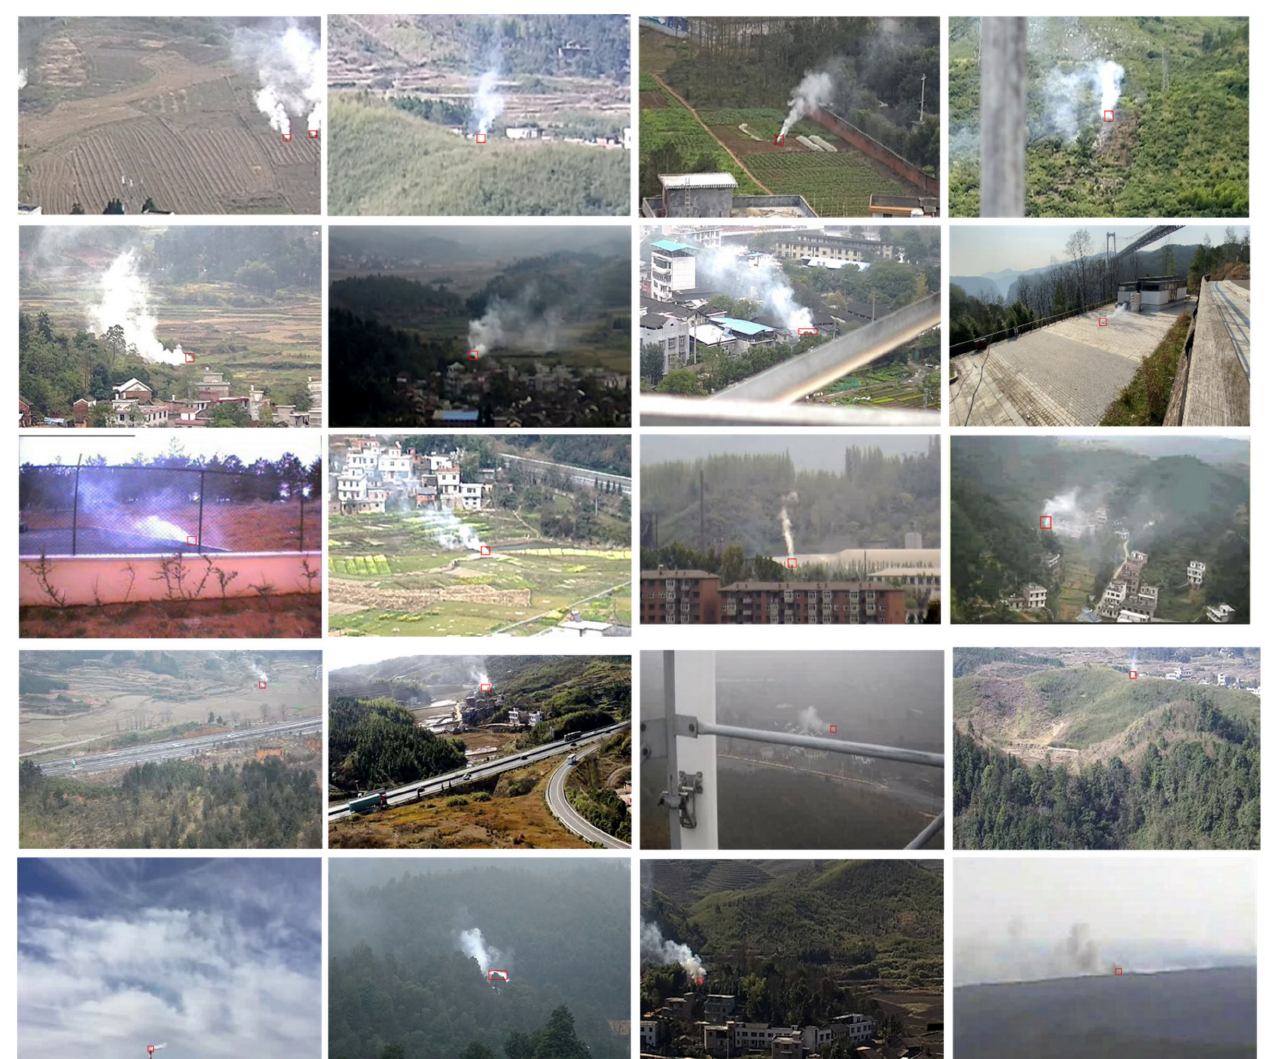
Figure 7. ROI areas for videos